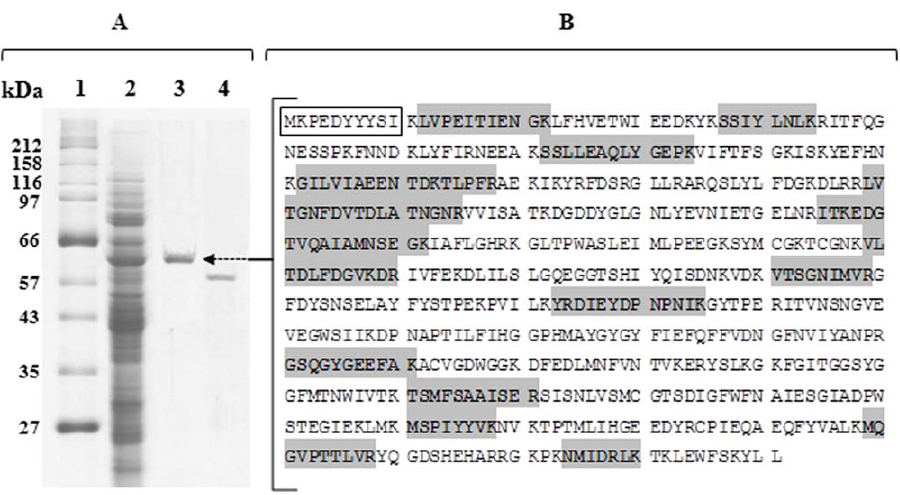
Figure 1. Purification and sequence analysis of APEH-3 Ss from Sulfolobussolfataricus . ( A ) SDS-PAGE of purified APEH-3 Ss ; lane 1, molecular weight markers (myosin 212.0 kDa, MBP- b -galactosidase 158.0 kDa, b -galactosidase 116.0 kDa, phosphorylase b 97.2 kDa, serum albumin 66.4 kDa, glutamic dehydrogenase 56.6 kDa, MBP2 E. coli 42.7 kDa, thioredoxin reductase 34.6 kDa and triosephosphate isomerase 27.0 kDa); lane 2, protein pattern of the cytoplasmic fraction obtained after cell lysis; lane 3, purified APEH-3 Ss ; lane 4, purified APEH Ss . ( B ) Amino acid sequence deduced from the APEH-3 Ss -coding gene ( sso2693 ). The peptides identified by LC-MS/MS are highlighted in grey and the N-terminal amino acid sequence of the purified protease is boxed.